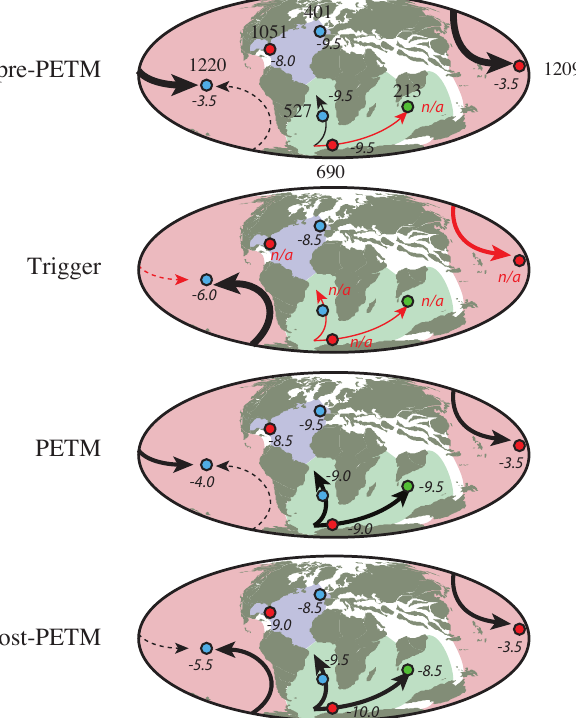
Figure 3. A conceptual model of the intermediate/deep-water mix- ing changes across the PETM as inferred from ε Nd records of intermediate/deep-water mass geometries. Arrow boldness reflects overturning circulation that could produce water mass geometries. Dashed arrows represent weak overturning. Italicized numbers indi- cate an ε Nd estimate interpreted from each site for the time period. The time periods are broadly divided into a pre-PETM period, in- cluding all data prior to the “trigger” as denoted in Fig. 2; the “trig- ger” period which slightly precedes and overlaps with the PETM; the PETM as defined by the CIE; and the post-PETM, including all data after the CIE. Red arrows indicate interpretations that are more speculative as the data are not available. The arrow directions reflect our interpretation of the general direction of flow, and are not meant to be viewed as precise flow paths. The paleogeographic distribu- tion of the continents is from Ocean Drilling Stratigraphic Network